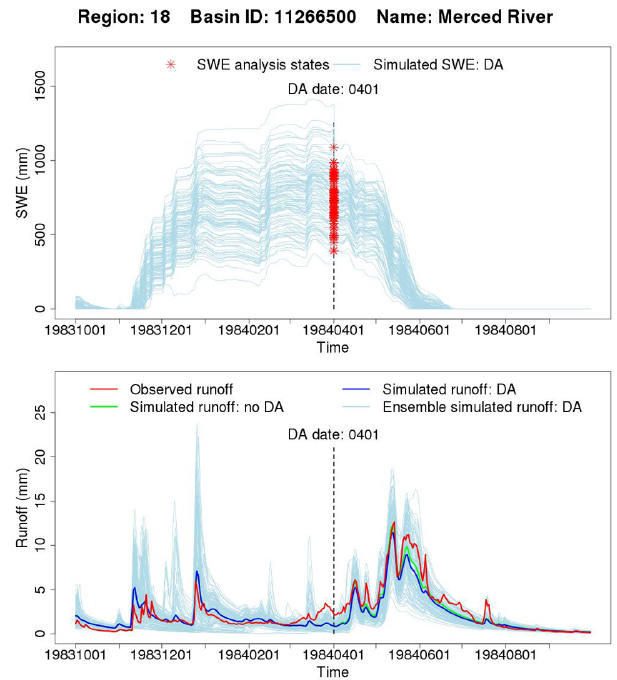
Figure 14. Time series plots for SWE and runoff for the Merced River for water year 1984. Light blue lines indicate individual en- semble member traces. Vertical black dashed line denotes the DA